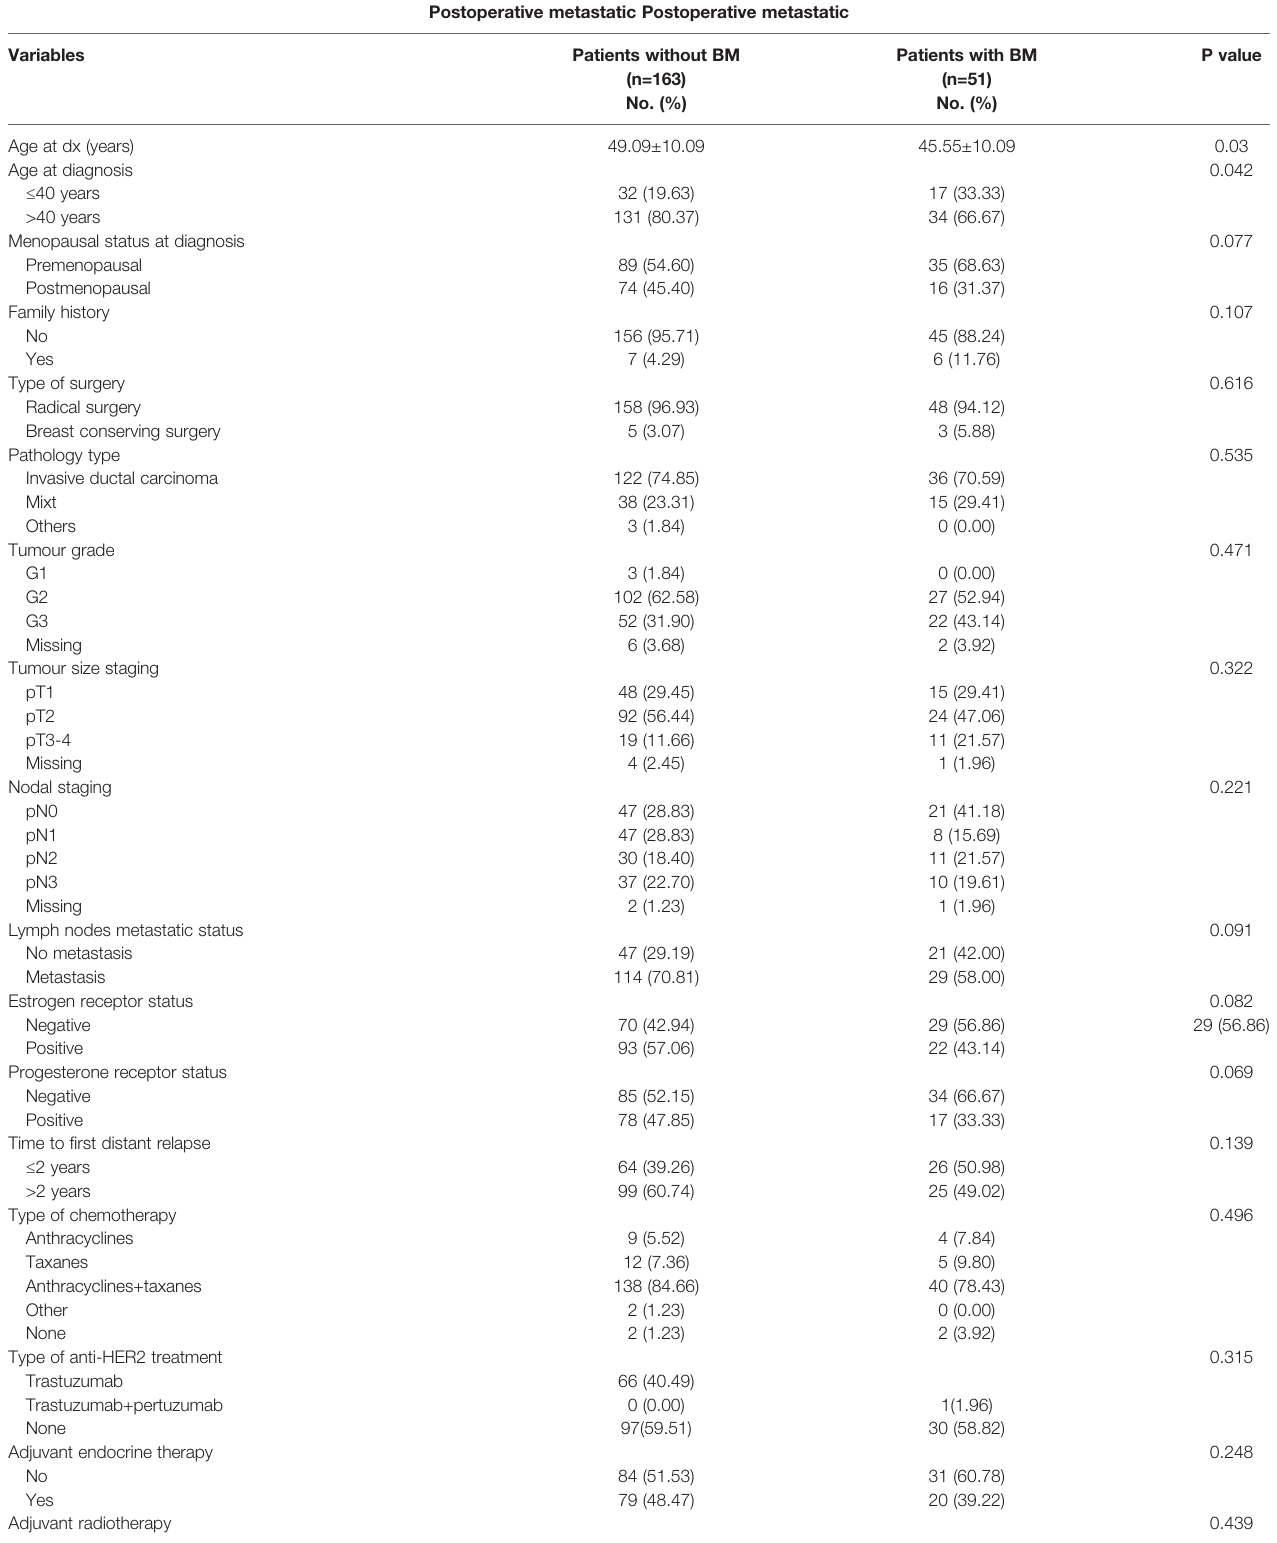
TABLE 1 | Risk factors of brain metastasis in Her2 positive postoperative breast cancer patients according to strati fi ed variables: univariate